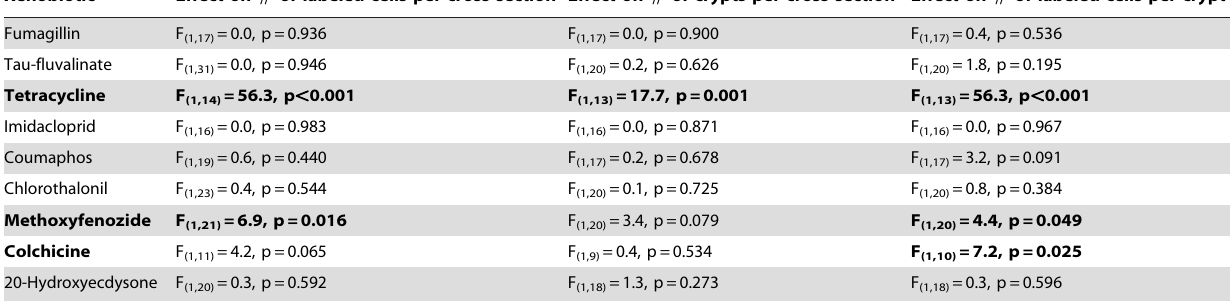
Table 3. Xenobiotic feeding effects * on ISC proliferation pooled across replicate